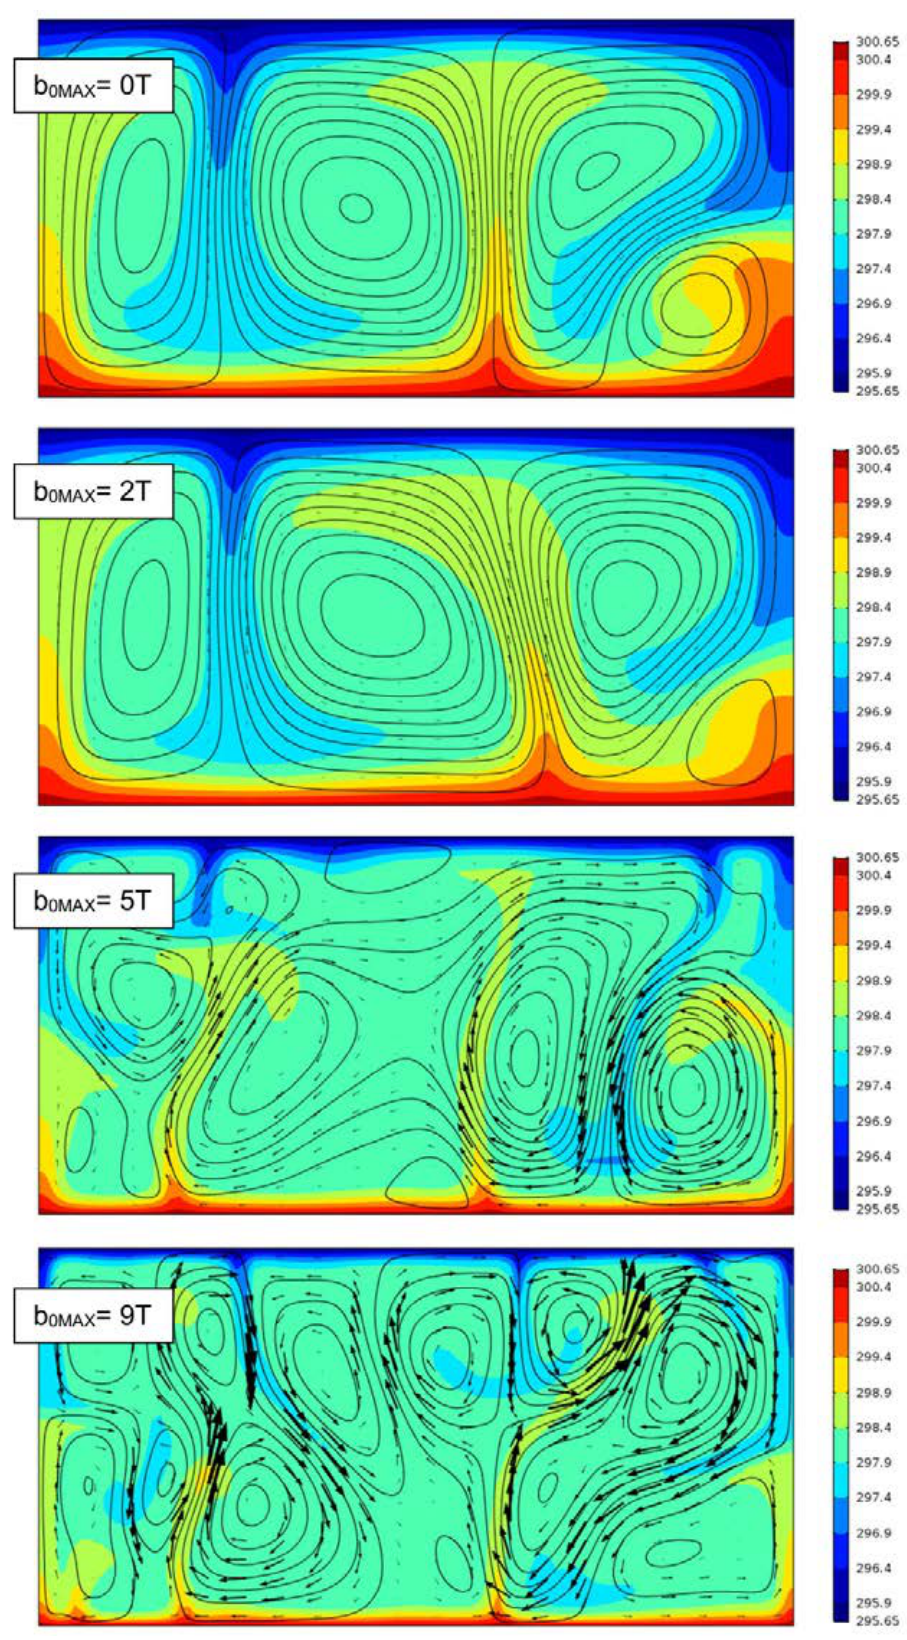
Figure 17. Temperature color maps with stream lines and velocity vectors for numerical simulations for Δ T = 5 °C. The velocity vectors are scaled ×2 in comparison to Figure 18.